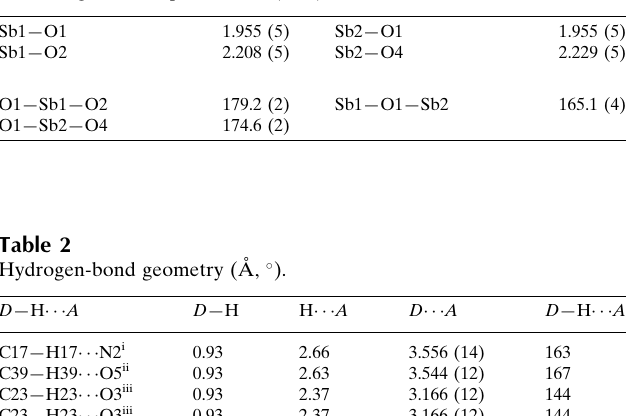
Selected geometric parameters (A˚ , (cid:1) ).